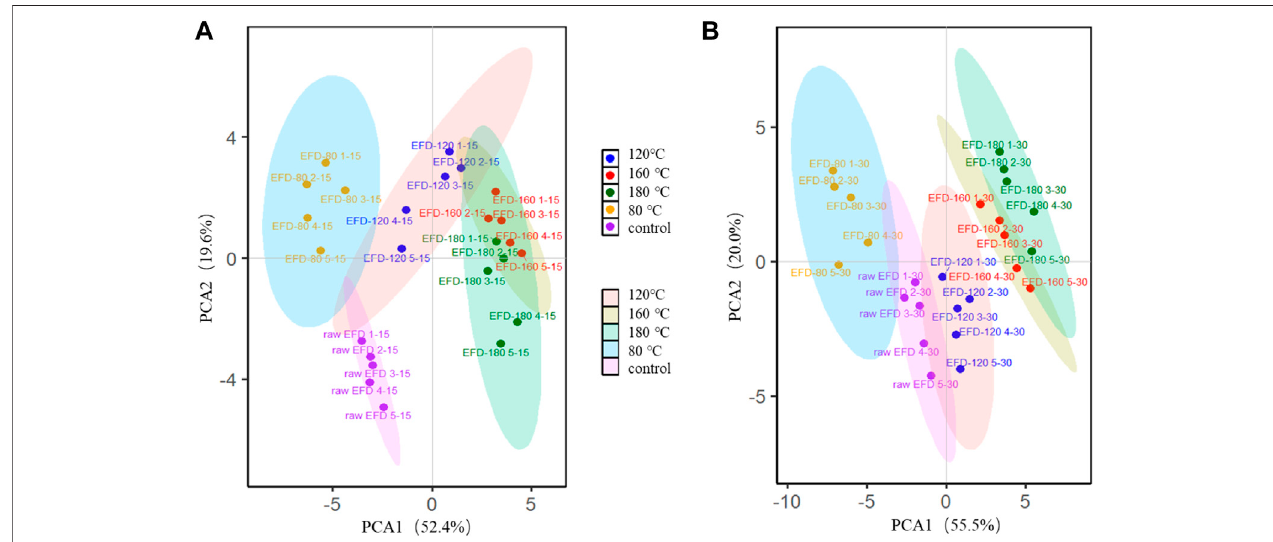
FIGURE 5 | Principal component analysis (PCA) of bacterial genera during AD for 15 days (A) and 30 days (B) of the erythromycin fermentation dregs (EFD) after